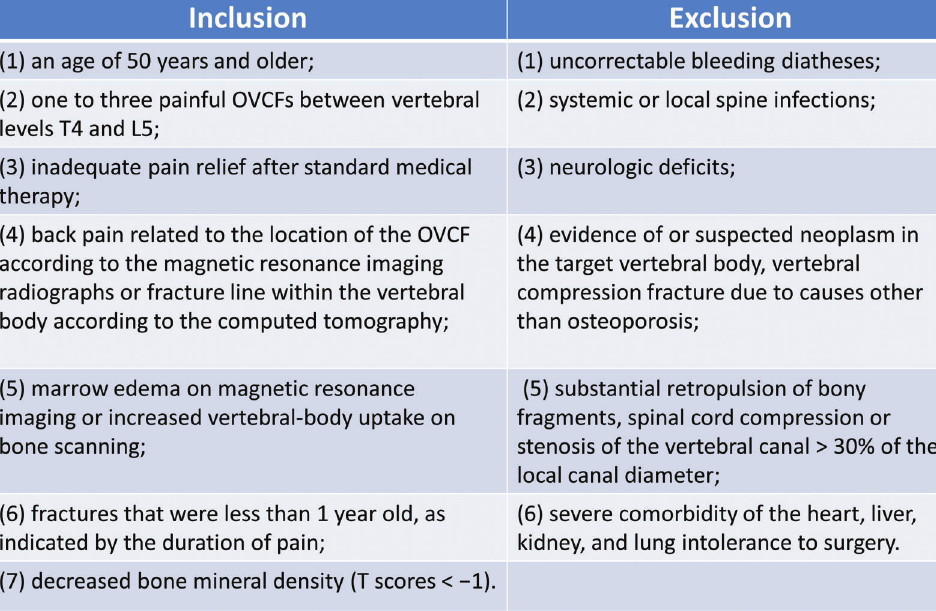
Figure 1 - Inclusion and exclusion